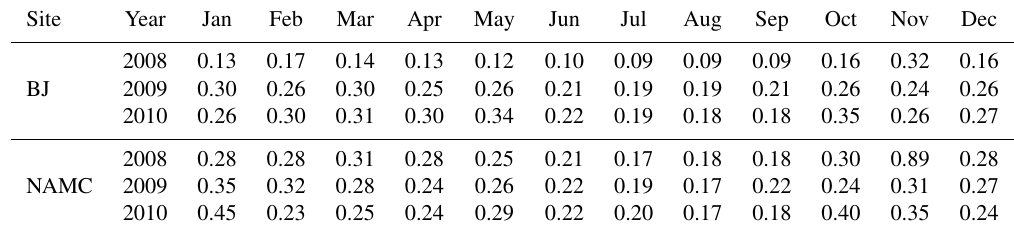
Table 3. The selected other schemes in Noah-MP. Options for different schemes Name of the option Dynamic vegetation Use table LAI; use FVEG = SHDFAC from input Canopy stomatal resistance Soil moisture factor for stomatal resistance Surface layer drag